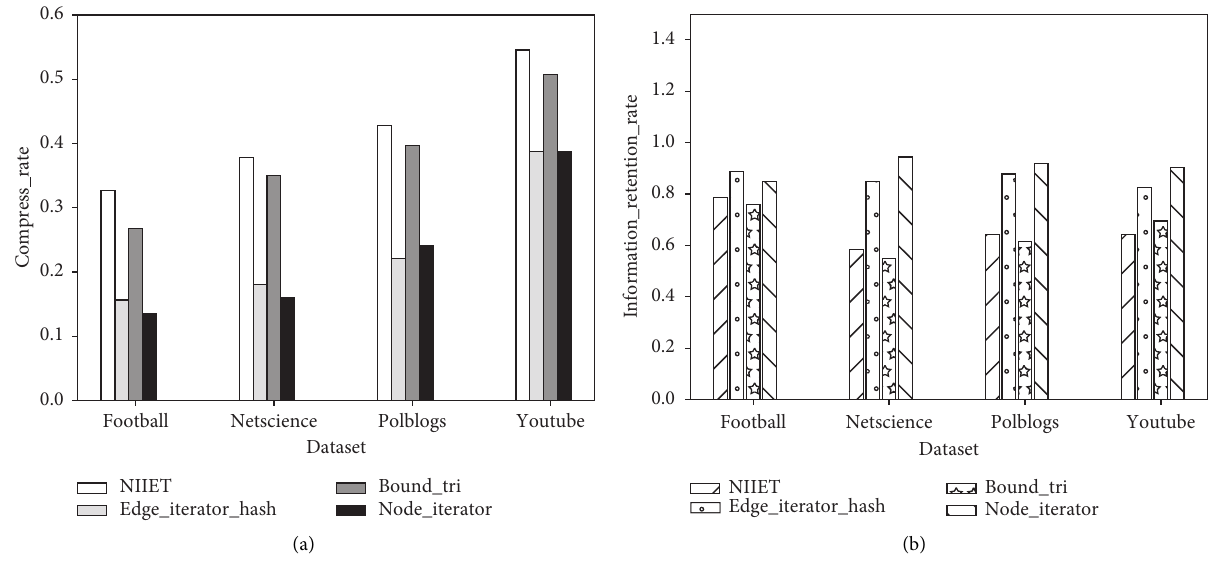
Figure 8: Comparison of the compression effect. (a) Compression rate. (b) Rate of information